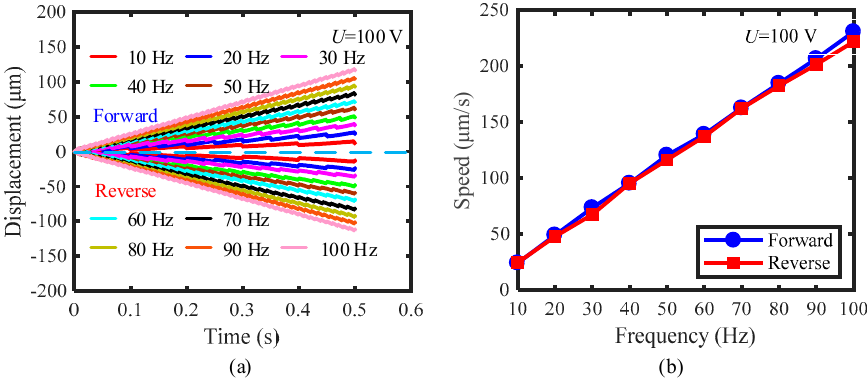
Figure 12. ( a ) The forward and reverse cumulative displacements of the improved actuator in 500 ms, obtained under the fixed driving voltage of 100 V and various driving frequencies (10 to 100 Hz), and ( b ) the corresponding speed changing with the driving frequency. Table 5. The detailed forward and reverse accumulative displacements in 500 ms, obtained under various driving frequencies (20 to 100 Hz), as well as the deviation analysis.